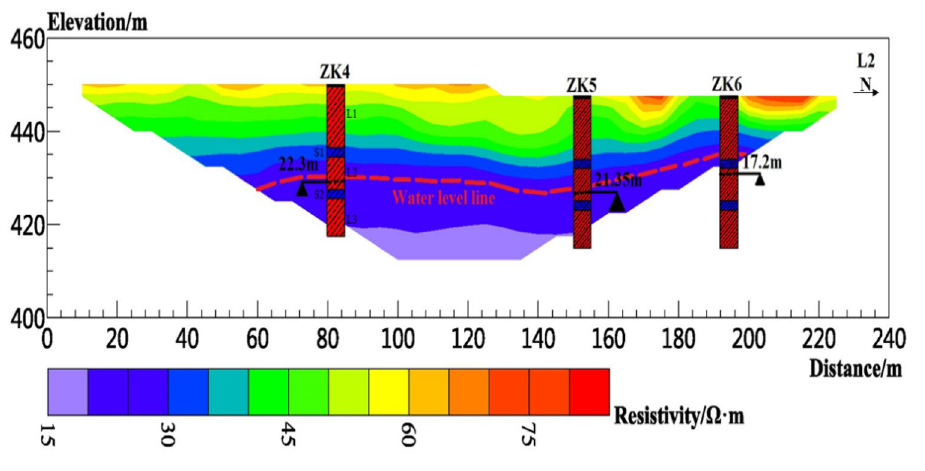
Figure 10. Resistivity profile of line